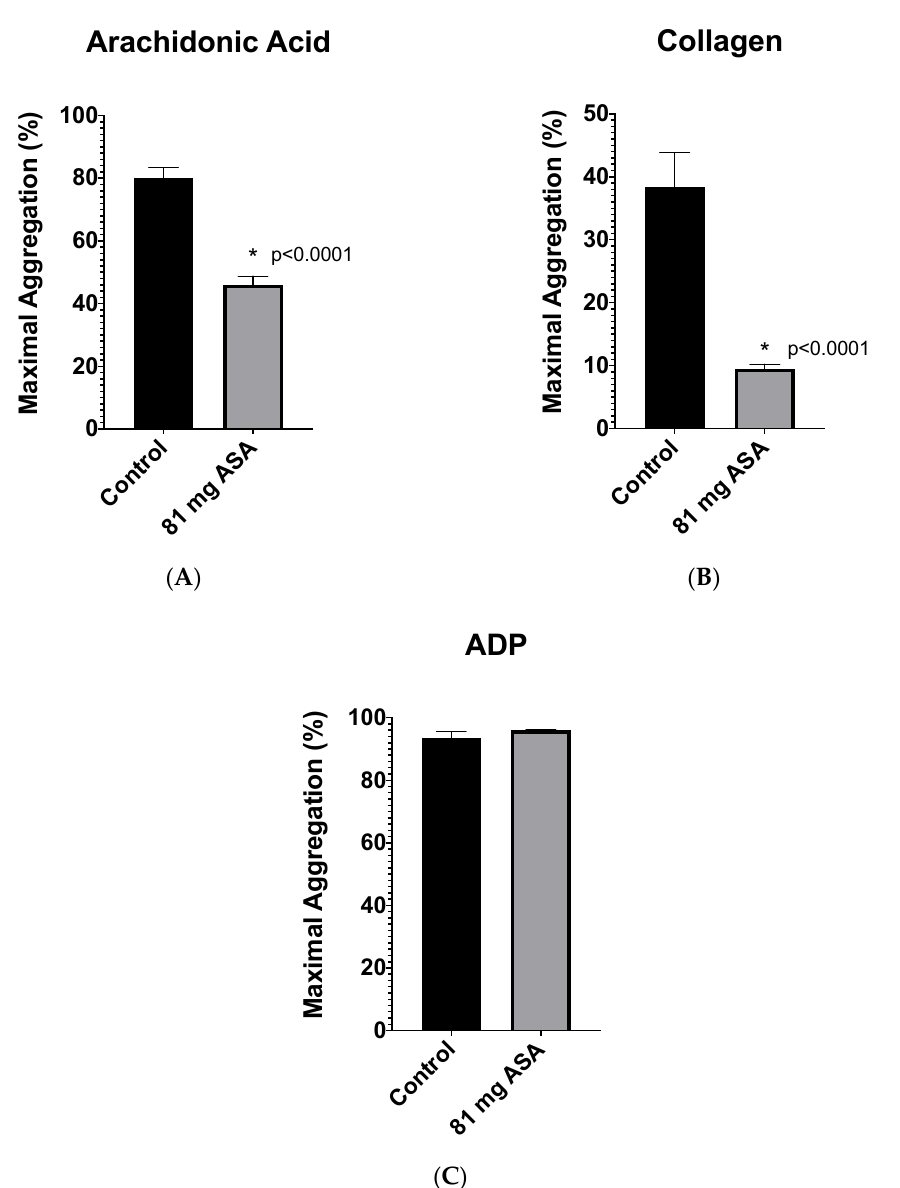
Figure 1. Plateletworks ® analysis between patients not on ASA (control, n = 20) and patients taking 81 mg aspirin (81 mg ASA, n = 40) using platelet activation agonists ( A ) arachidonic acid, ( B ) collagen, and ( C ) adenosine 5 ′ -diphosphate (ADP). Error bars represent standard error of the mean. * represents significant difference between control and 81 mg ASA pa- tients.